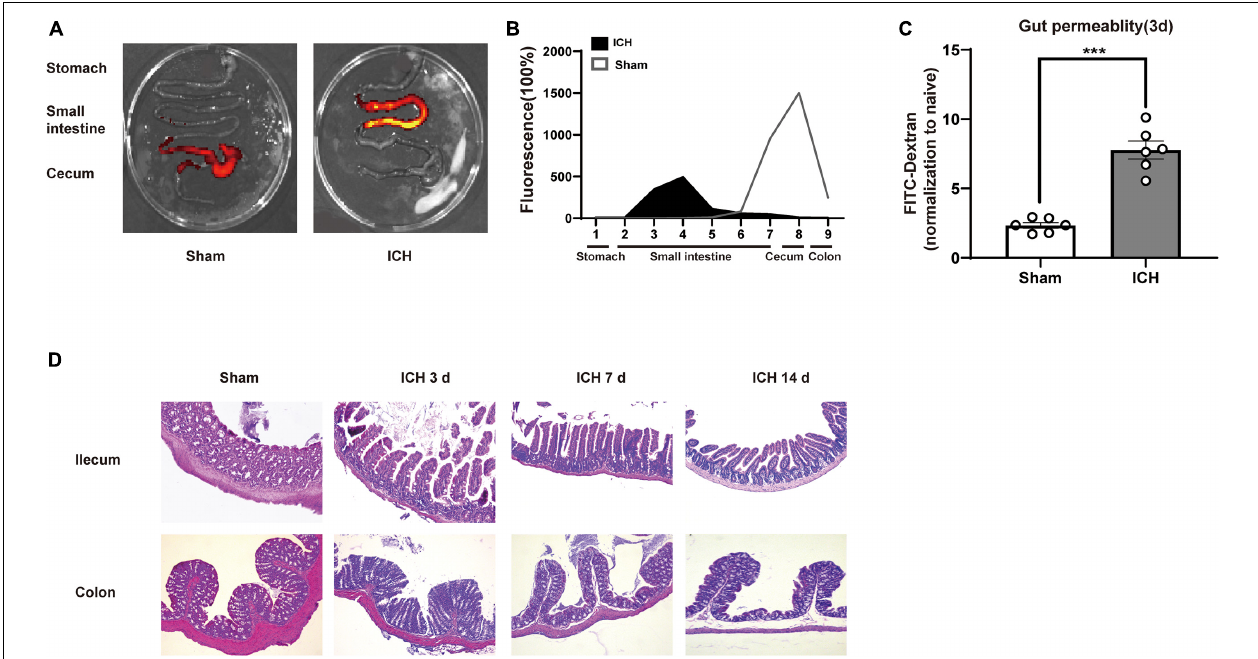
FIGURE 2 | Gastrointestinal dysfunction after ICH. (A) Intestinal motility was measured 3 days after sham and ICH surgery. Representative fluorescence images of the complete gastrointestinal tract 1 h after gastric instillation of FITC-dextran showing retention of the fluorescence intensity in intensity segments after ICH. (B) Quantification of fluorescent intensity in intestinal segments ( n = 6 per group). (C) Intestinal permeability was measured by oral gavage of FITC-dextran (4 KD) with subsequent analysis of the level plasma of FITC-dextran. There was a significant increase in the ICH mice than the sham group after 3 days. ( n = 6 per group). (D) Intestinal histopathologic changes after ICH 3, 7, and 14 days of ICH. Hematoxylin and eosin staining shows thinning of the layers of epithelium and muscularis mucosae; loss of crypts and glands; edema of the lamina propria; and thickened and shortened villi at the histomorphometric level ( n = 3 per group). Data are expressed as the mean ± standard error of the mean. *** P < 0.001 vs . sham